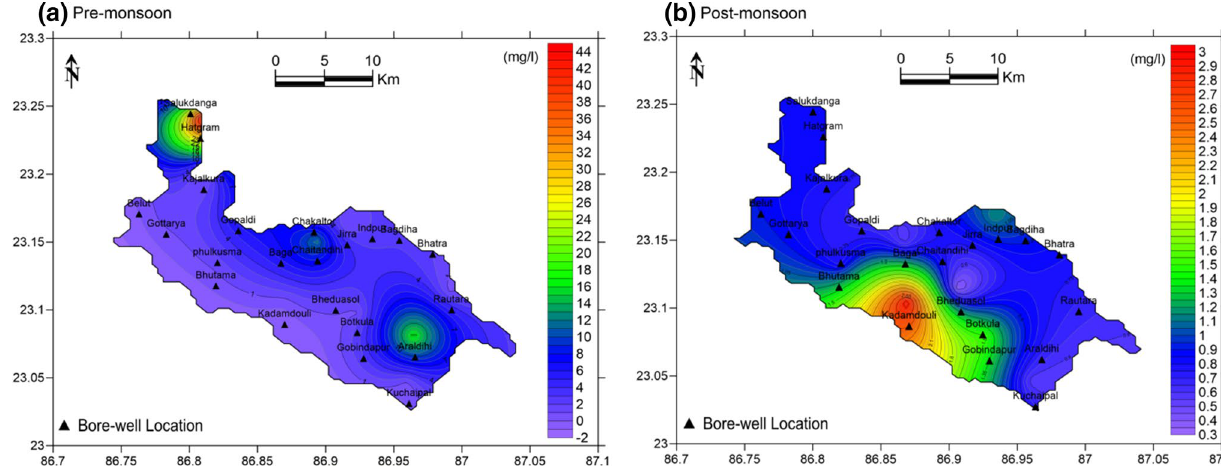
Fig. 8 Spatial distribution of Fe 2+ ; a PrM; b